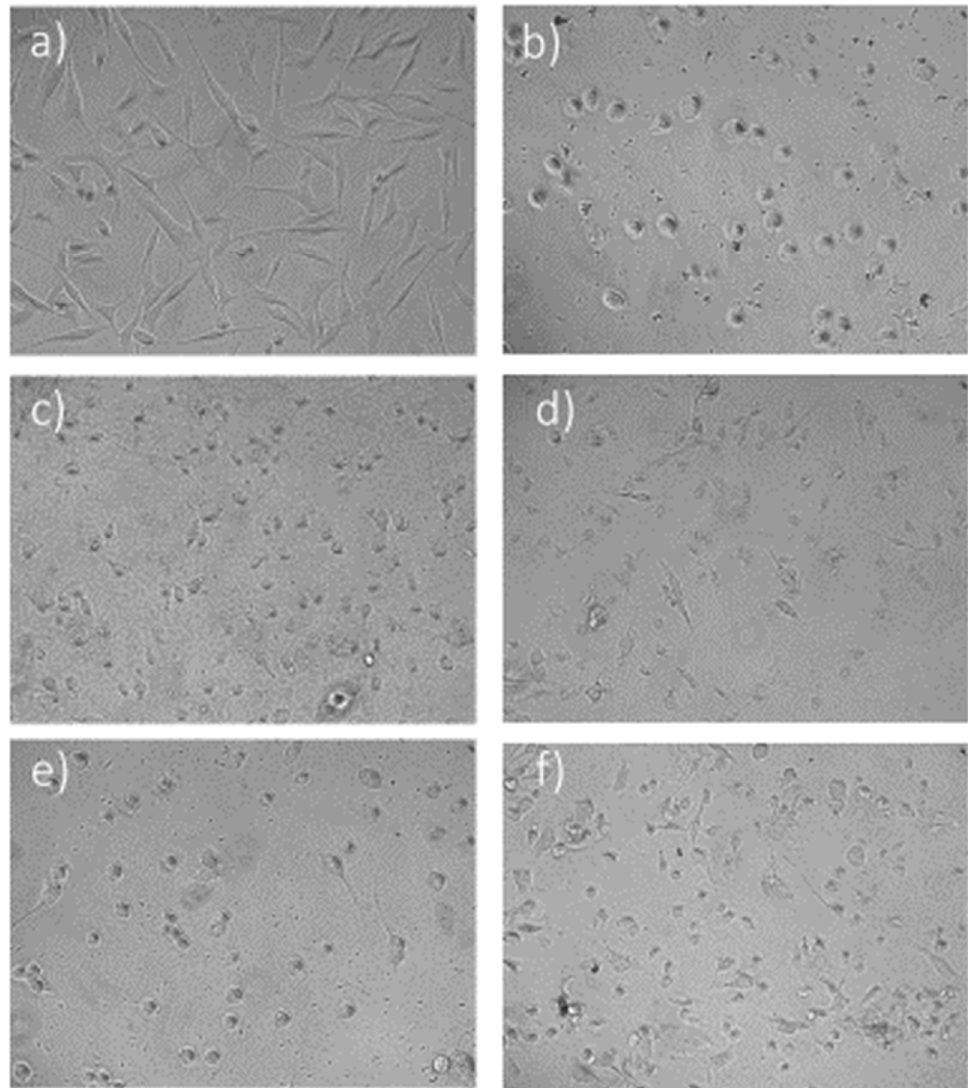
Figure 2. Morphology of WM-266-4 cells when exposed to: ( a ) medium (control); ( b ) extract of curcuma (5 mg/mL); ( c ) extract of goji berry (100 mg/mL); ( d ) extract of horsetail (100 mg/mL); ( e ) extract of grape merc and seeds (20 mg/mL); ( f ) extract of rosemary (5 mg/mL). Magnification 200×.